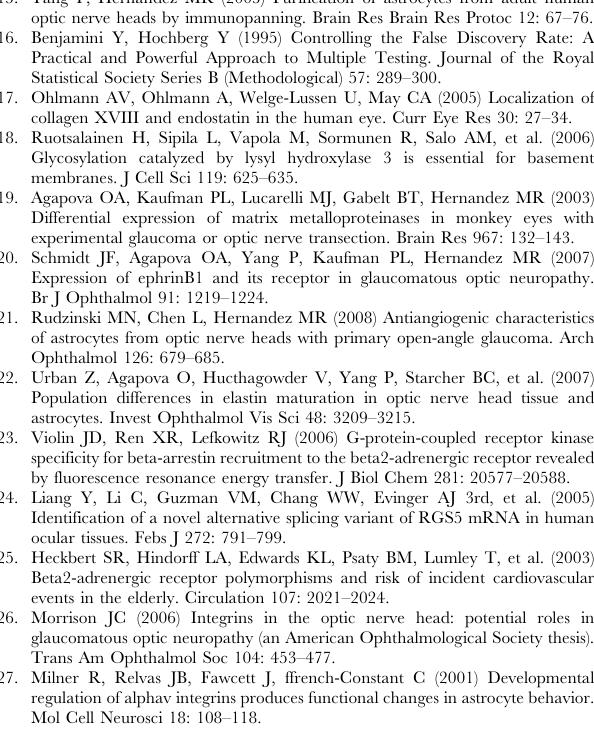
Table S7 Quantitative RT-PCR primer information. RT-PCR primer infortion Table S8 Primary Antibodies Used in this study. Information on the primary antibodies used in this